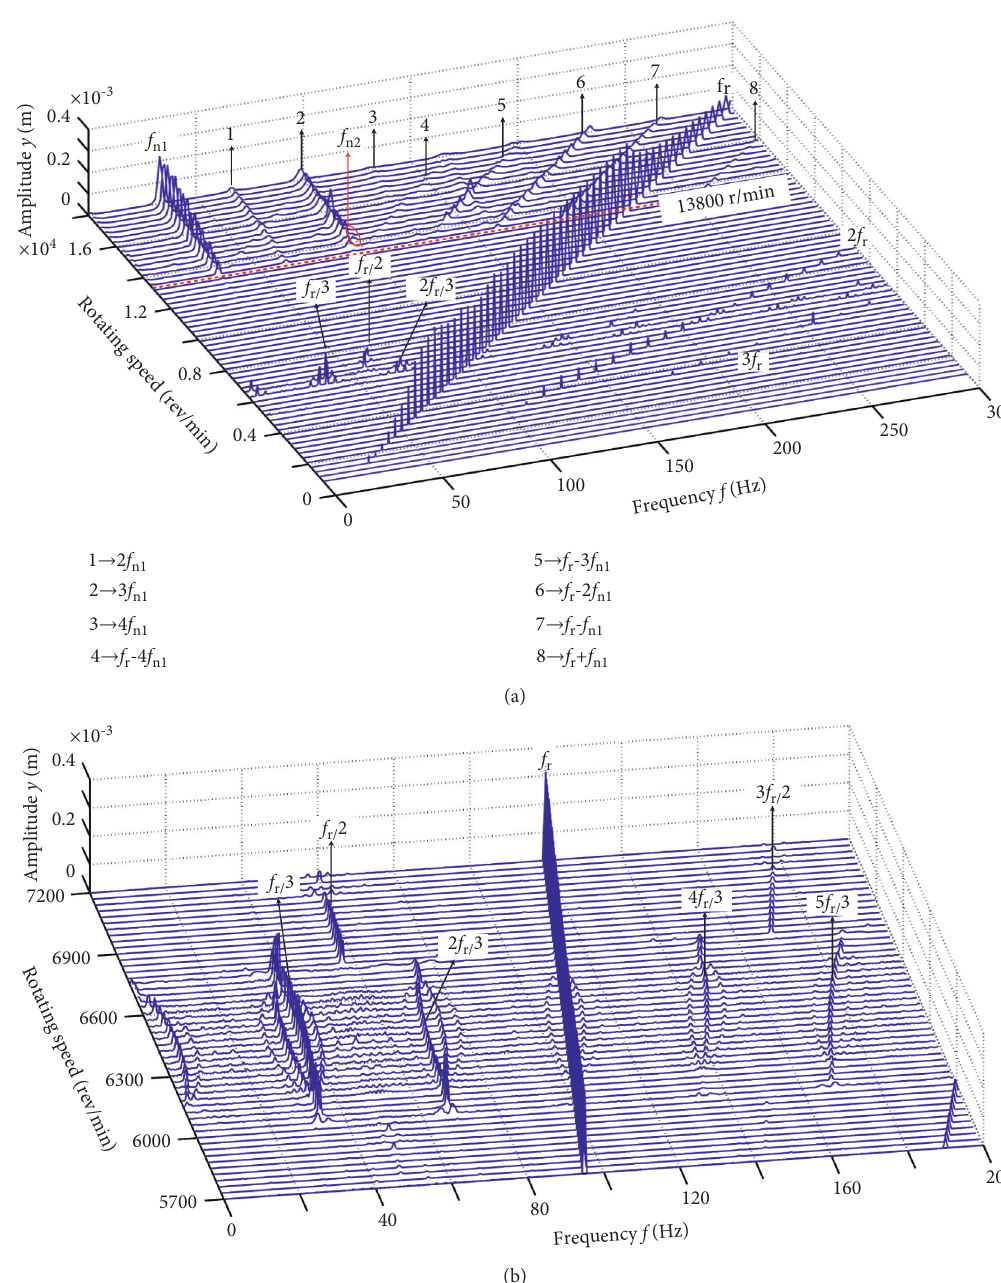
Figure 6: Spectrum cascade of the right journal. (a) ω ∈ [600, 18000]r/min and (b) ω ∈ [5700,